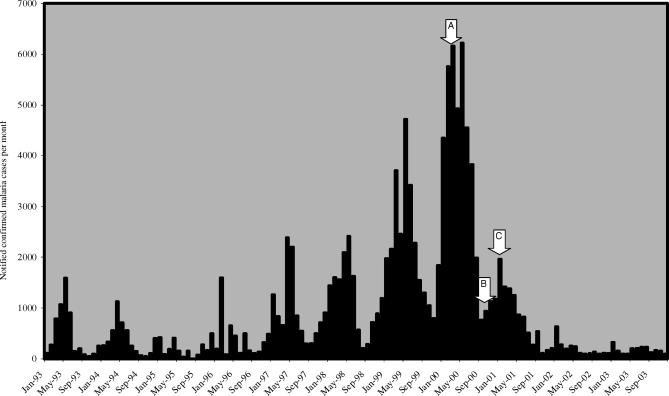
Number of Notified Malaria Cases in KwaZulu–Natal by Month (January 1993–December 2003)The number of cases is given in relation to season (peak transmission from January to May, inclusive) and timing of significant malaria control interventions: A indicates reintroduction of DDT for IRS of traditional structures in KwaZulu–Natal in March 2000; B indicates introduction of IRS in southern Mozambique in October 2000; and C indicates implementation of AL as first-line treatment of uncomplicated falciparum malaria in KwaZulu–Natal in January 2001.